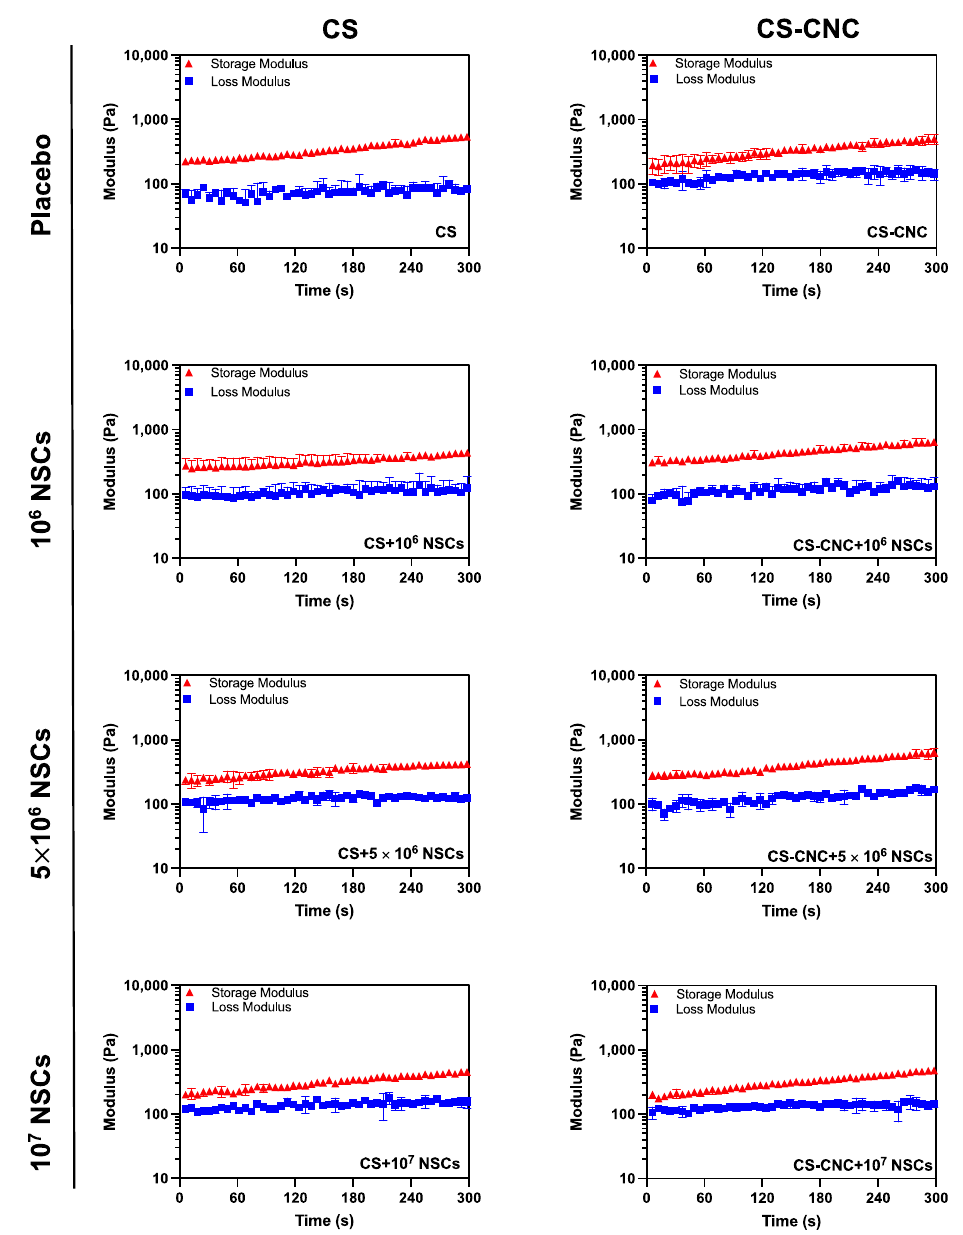
Figure 3. Effect of NSCs on hydrogel gelation kinetics. Gelation time of injectable cell-laden hydrogels determined by time at crossover G’ and G” ( n = 3).